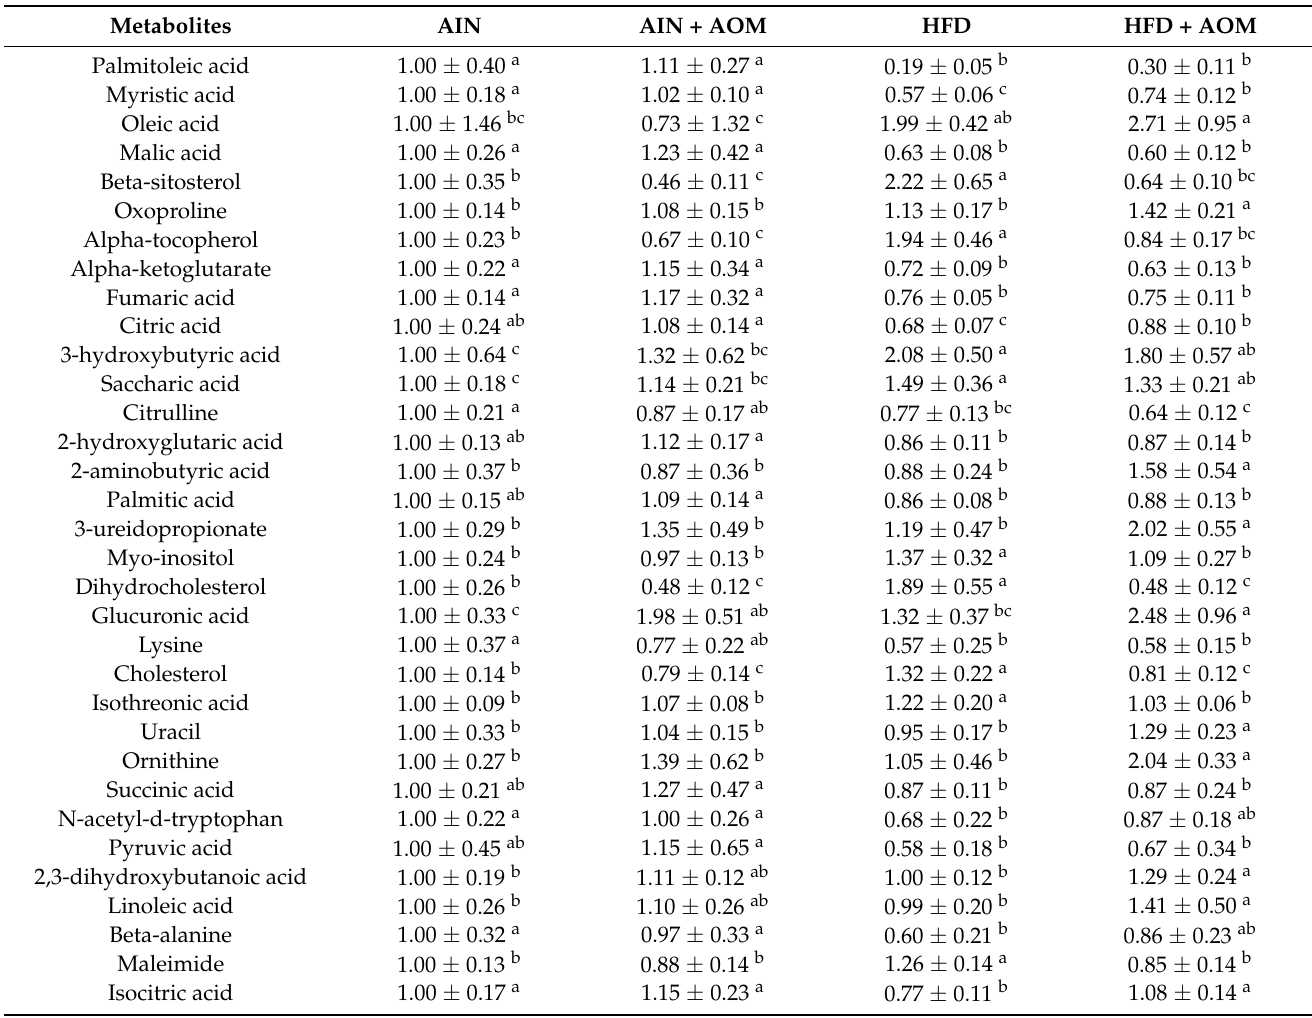
Table 1. The effect of HFD feeding and AOM treatment on the abundance of plasma